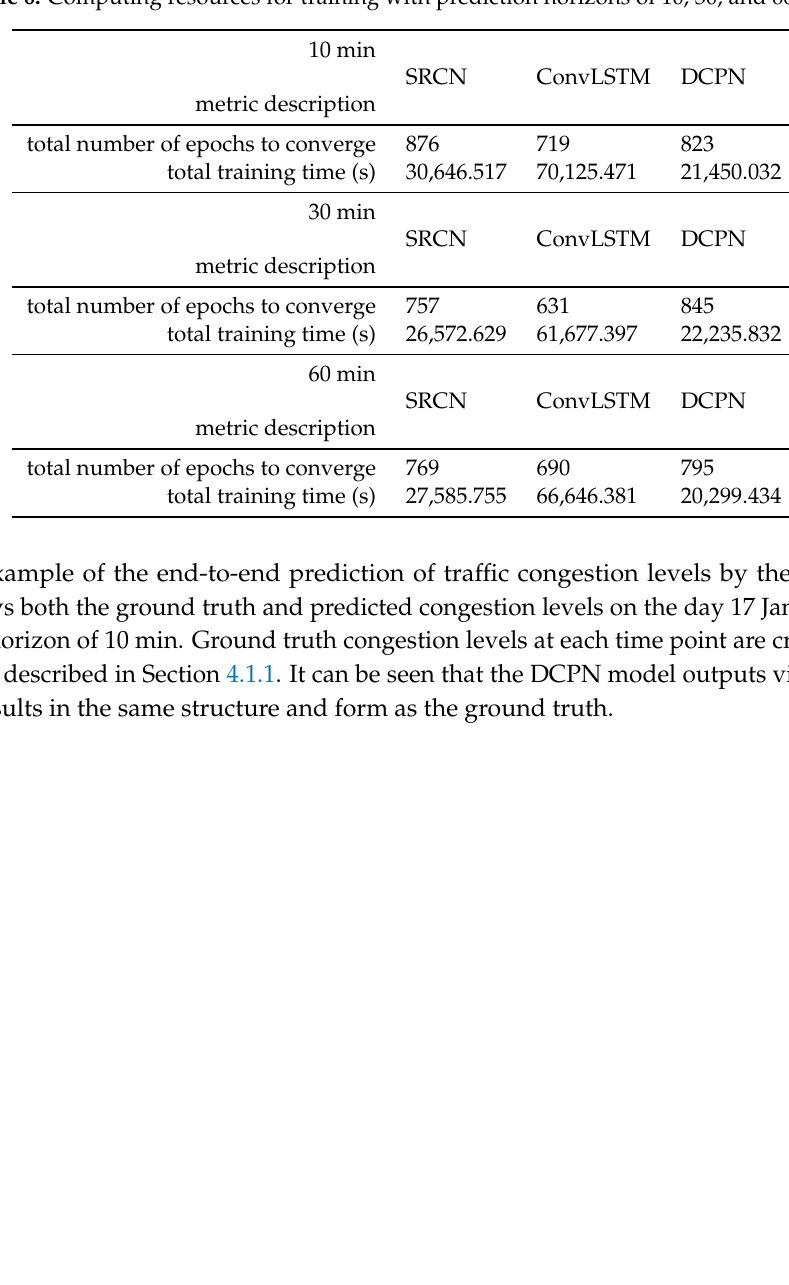
Table 6. Computing resources for training with prediction horizons of 10, 30, and 60